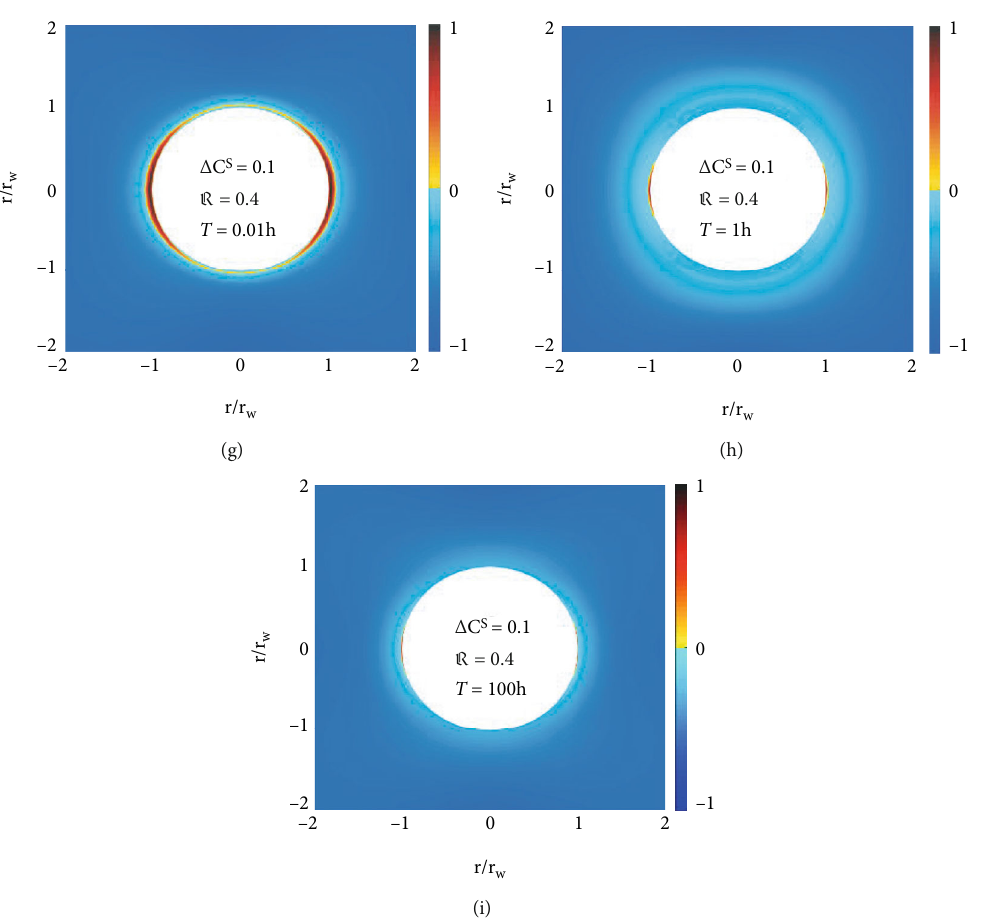
Figure 15: Damage zone around the wellbore (a) 0.01h, (b) 1h, and (c) 100 h after drilling for a re fl ection coe ffi cient of 0.2; (d – f) for a re fl ection coe ffi cient of 0.3; and (g – i) for a re fl ection coe ffi cient of